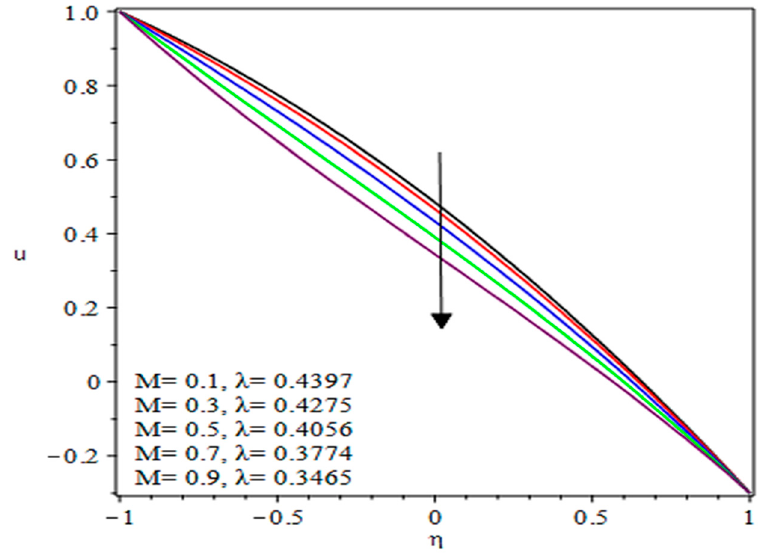
ξ= 0 by fixing = 0.1 K and